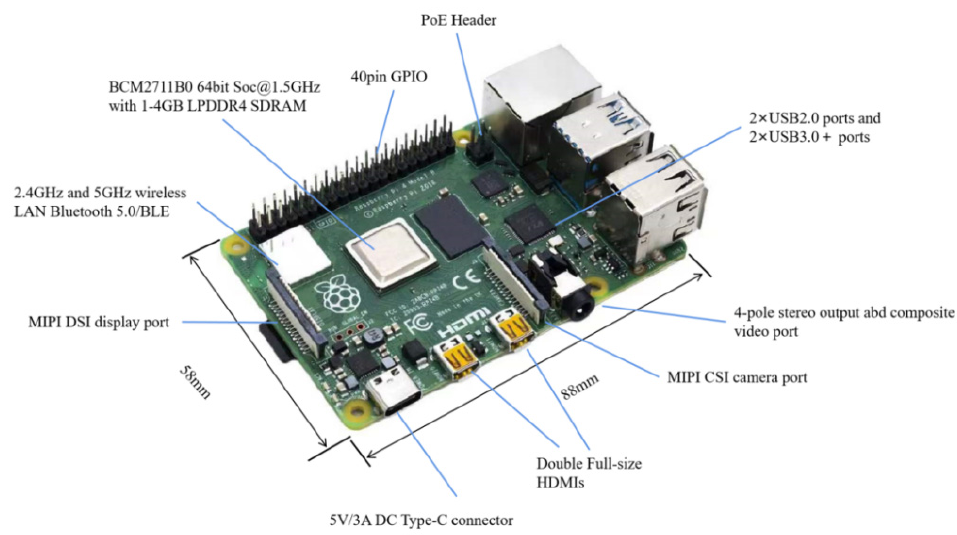
Figure 2. Raspberry Pi 4B Microprocessor.